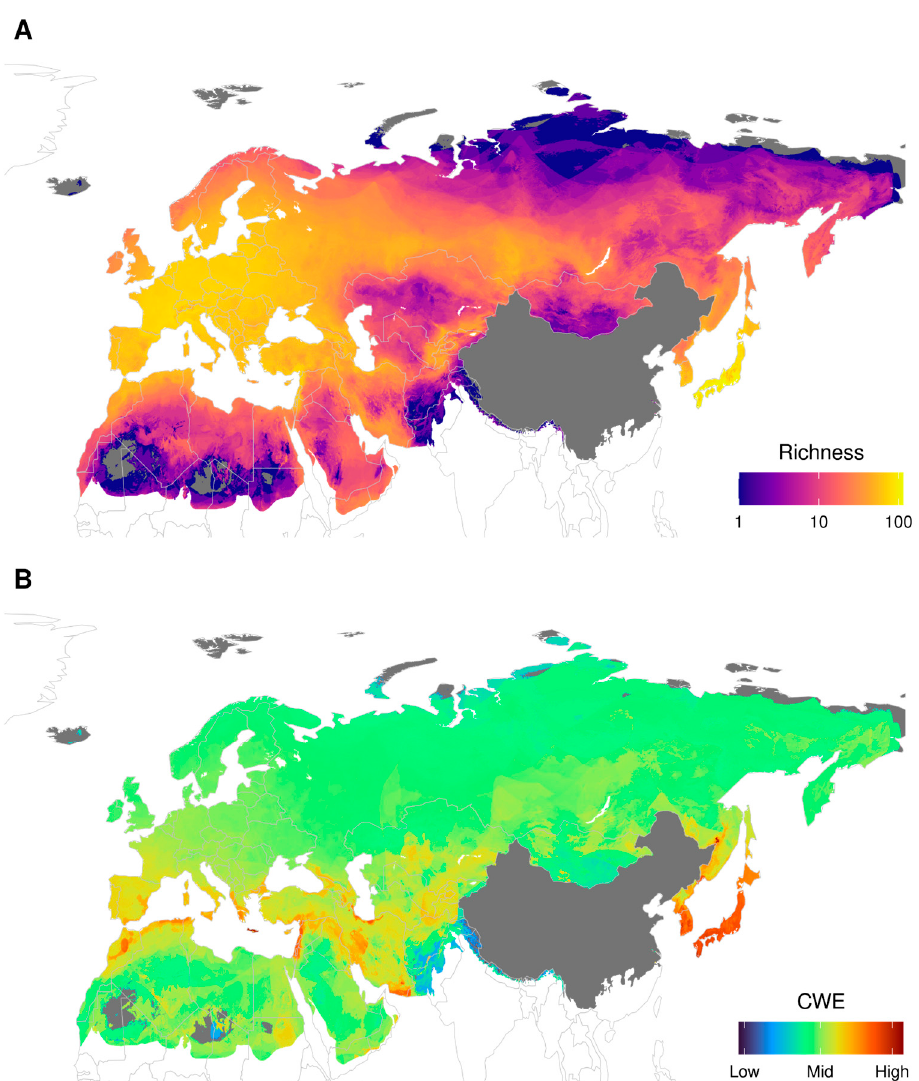
Figure 1. ( A ) Distribution of Odonata richness and ( B ) corrected weighted endemism (CWE) of Palaearctic odonates. Grey shading indicates the parts of the Palearctic for which our data are insufficient to make predictions.